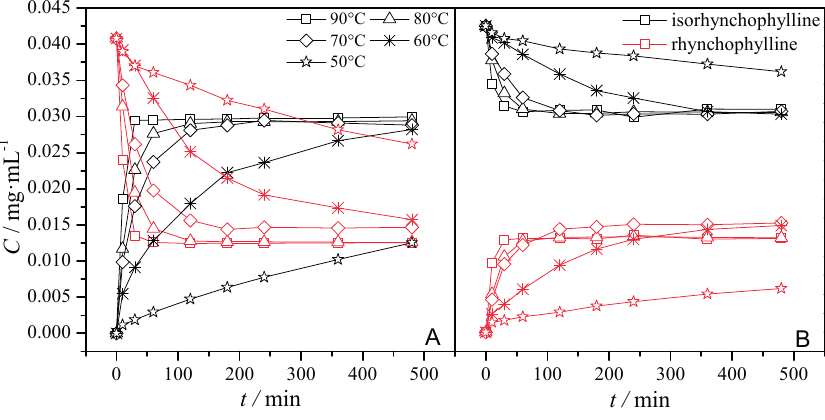
Figure 2. Effect of time-temperature conditions on the conversion rates of rhynchophylline ( A ) and isorhynchophylline ( B